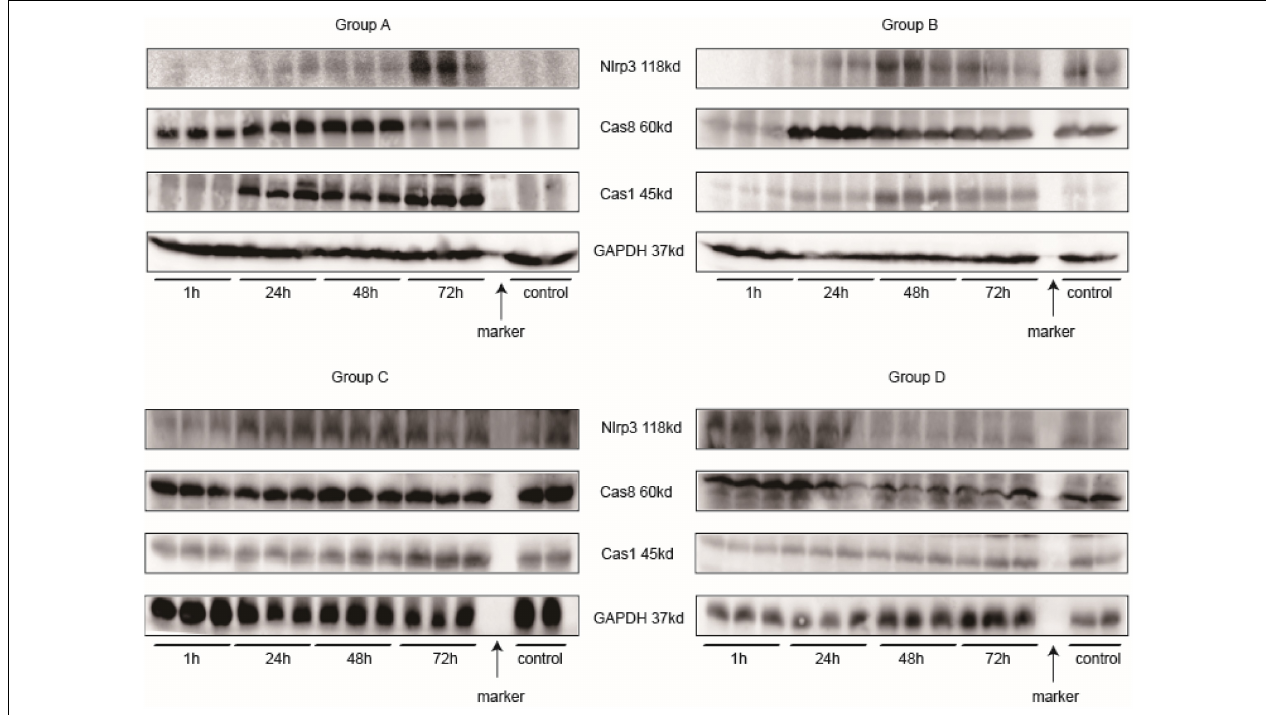
FIGURE 12 | Western blotting. Every three samples next to each other on the left of the marker belong to the same time point. The two samples on the right of the marker are